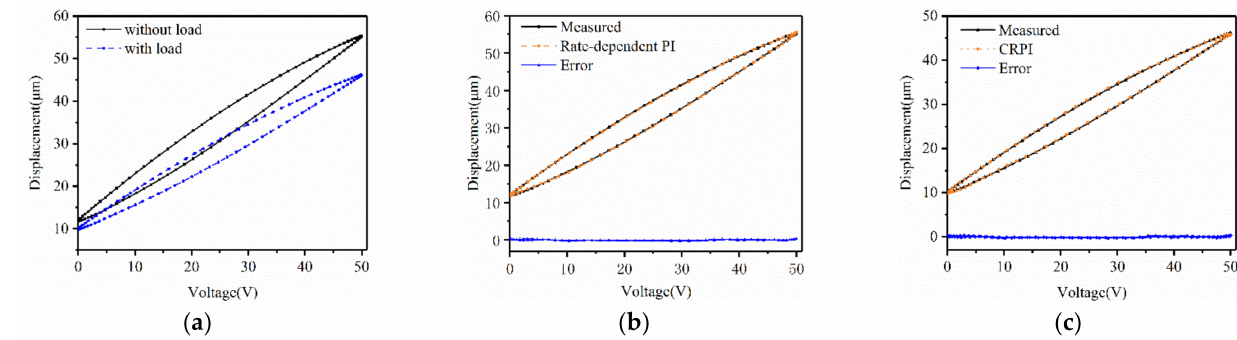
Figure 6. ( a ) Measured displacement with and without load; ( b ) Predicted and measured displacements of rate-dependent PI and errors; ( c ) Predicted and measured displacements of the cross-coupling rate-dependent Prandtl–Ishlinskii (CRPI) method and errors.